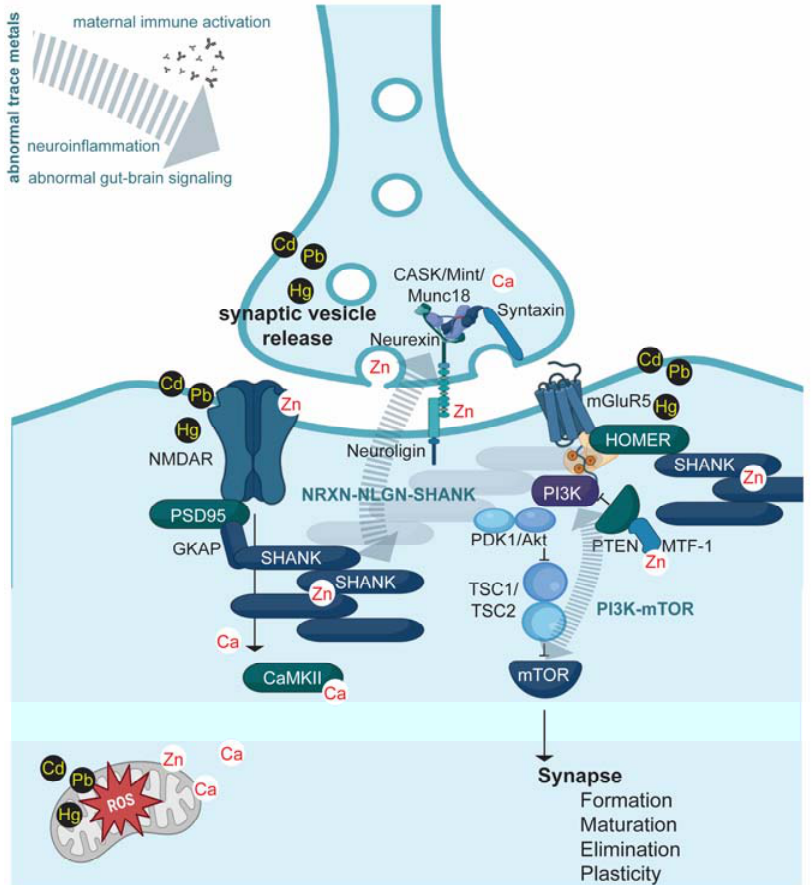
Figure 2. A model for the effects of metals and their contribution to ASD pathology. By considering metal profiles instead of isolated metals, the presence of heavy metals and deficiency in the essential metal zinc can be consolidated into one non ‐ genetic risk factor for ASD. Together, these metal abnormalities will affect many biological processes in the body. However, direct and indirect effects (i.e., through altered gut ‐ brain signaling, inflammatory cytokines, autoantibodies) on the NLGN ‐ NRXN ‐ SHANK and mTOR/PI3K pathway have been reported, which links this non ‐ genetic risk factor to well ‐ described pathomechanisms of genetic and other non ‐ genetic factors, further consolidating multiple risk factors in one ASD ‐ linked mechanism. Research has shown that both synaptic NLGN ‐ NRXN ‐ SHANK and mTOR/PI3K pathway activation is modified by zinc and calcium and affected through the interactions of toxic metals with NMDARs, mGluR5, and proteins mediating presynaptic vesicle release. The possible interaction of the metals with pathway proteins is indicated in the figure.